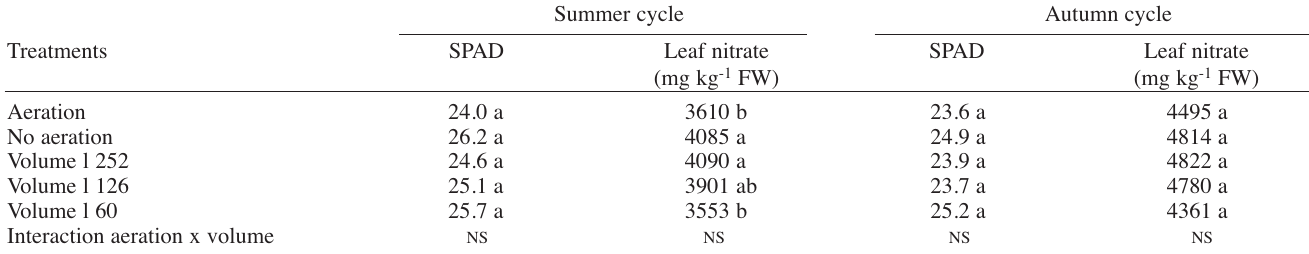
For each factor, values in each column followed by the same lower-case letter are not statistically different (SNK Test, P≤0.05). NS = not significant.